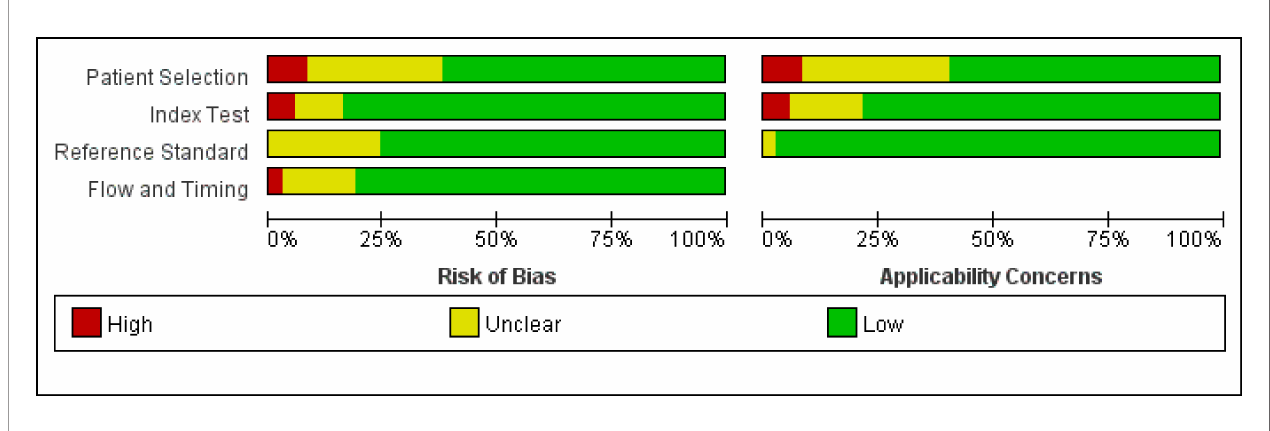
FIGURE 2 | Graphical display for Quality Assessment of Diagnostic Accuracy Studies (QUADAS-2) results regarding the proportion of studies with low, high, or unclear risk of bias.